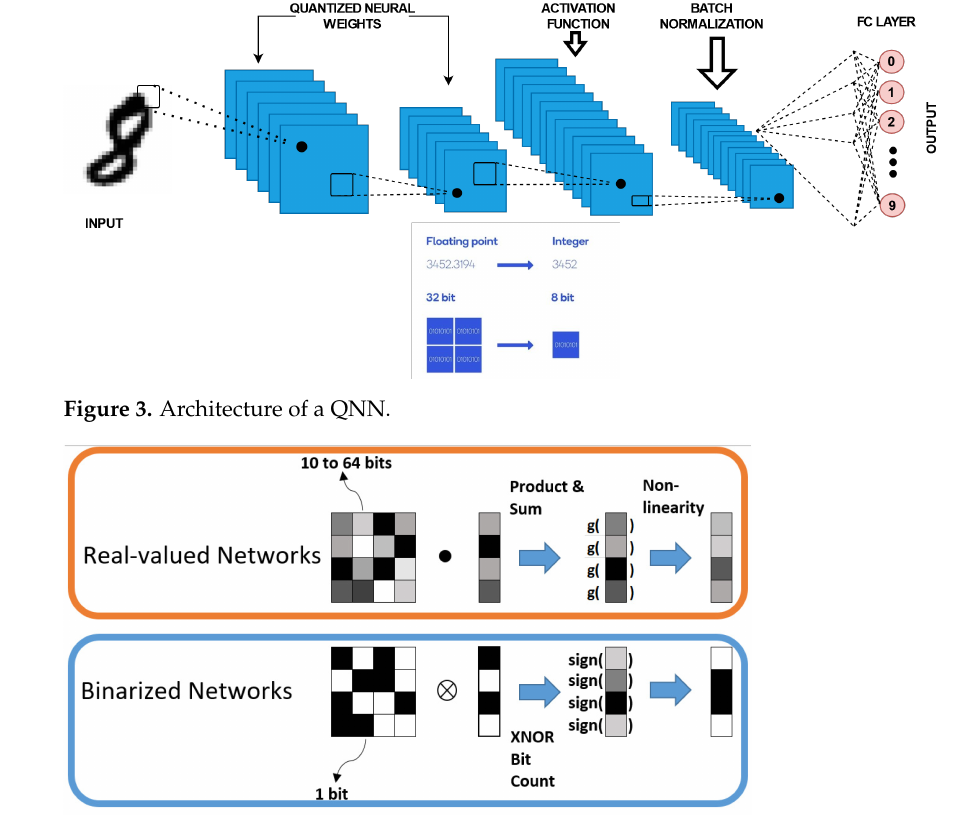
Figure 4. The difference weight implementation and distribution between a full precision neural network and a binarized neural network